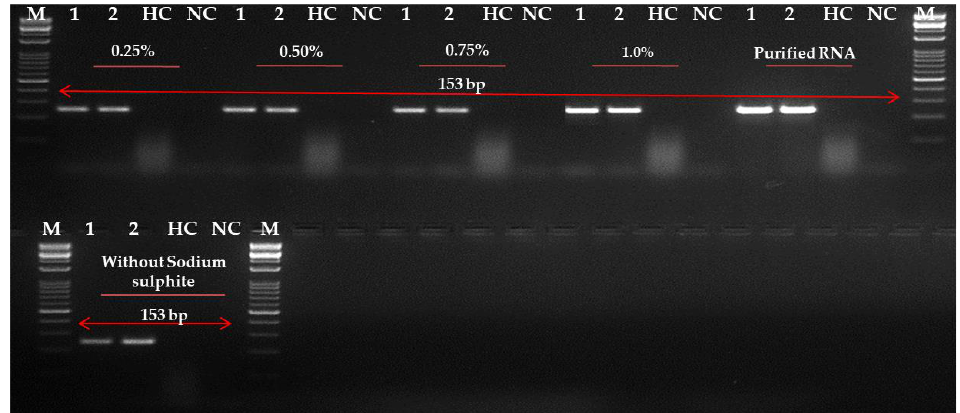
Figure 6. One-step reverse transcription-recombinase polymerase amplification (RT-RPA) optimi- zation for potato leafroll virus (PLRV) detection using forward and reverse primer LRRPAF3/R3- Set C. Utilization of two RNA isolation methods, viz. , cellular disc paper-technique [28] and Spec- trum TM Plant Total RNA kit (Sigma-Aldrich, St. Louis, MO, USA). The agarose gel images visualize the amplicons when the respective concentration of sodium sulphite ranging from 0.25 to 1.0% for the respective method of RNA extraction has been used. HC: healthy potato mini tuber sample, NC: negative control, Lane M: 50 bp